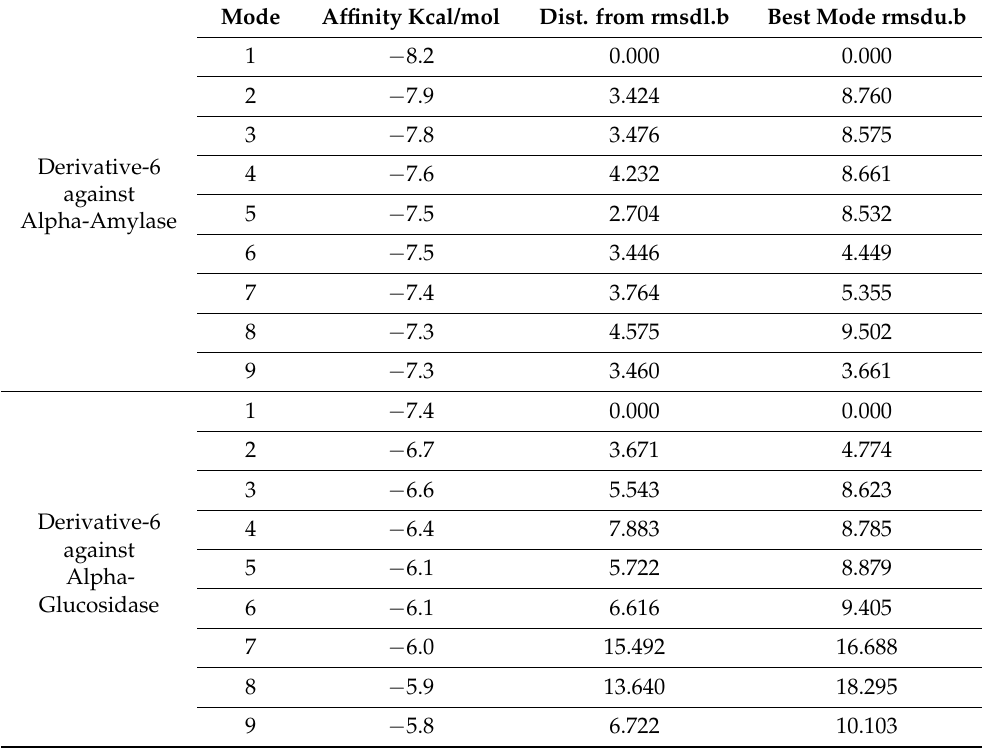
Table 4. Represent the binding affinities and best mode RMSD of analog 6 against Alpha-amylase and Alpha-glucosidase.